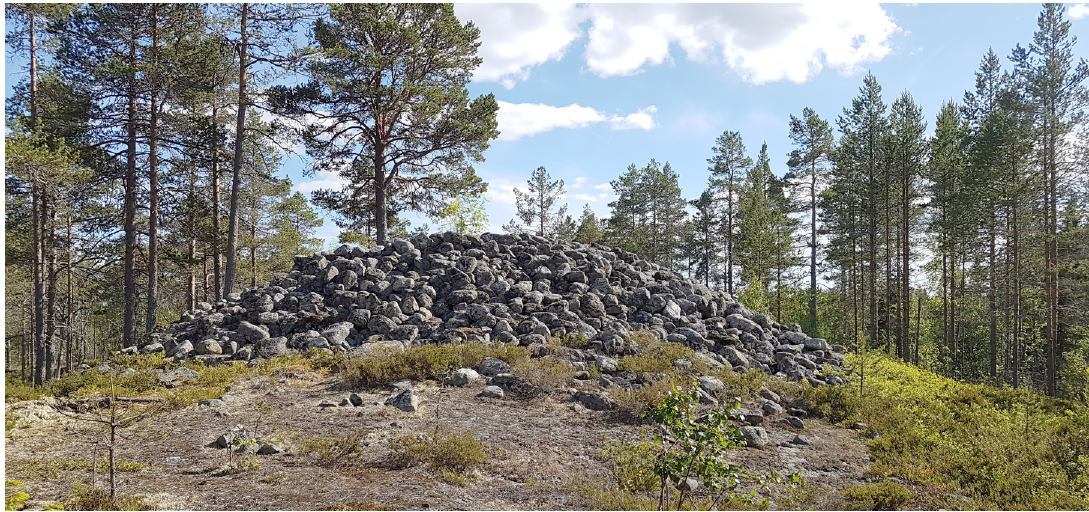
Figure 4: A stone cairn along the coast of northern Sweden, located south of Umeå in the province of Västerbotten. Photo by